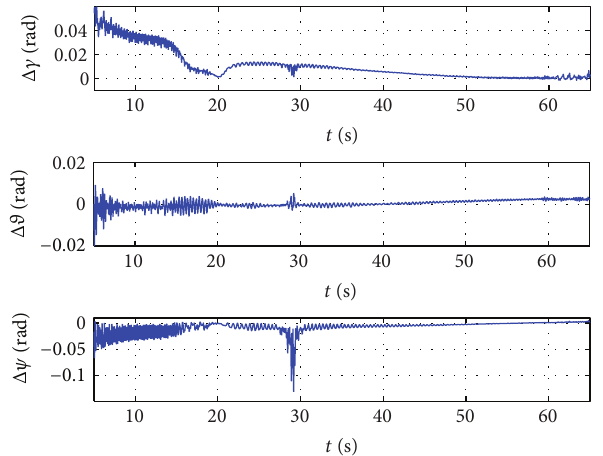
Figure 6: The process of the fine alignment by the in-flight alignment mode based on Kalman